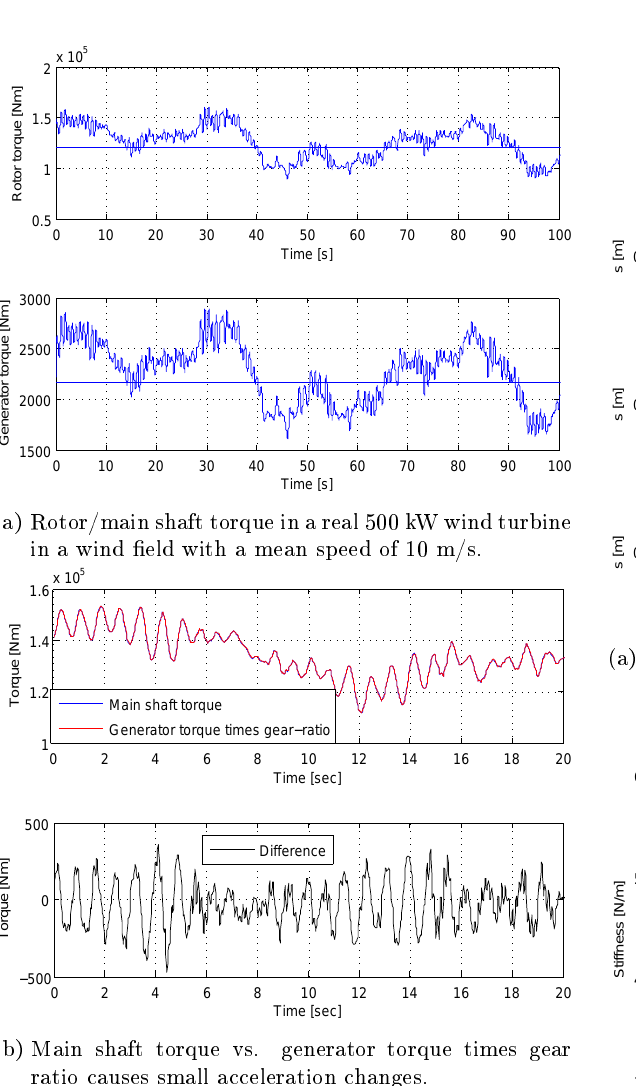
(b) Main shaft torque vs. generator torque times gear ratio causes small acceleration changes. Figure 11: Realistic input torque for the realistic multi- body planetary gearbox model .